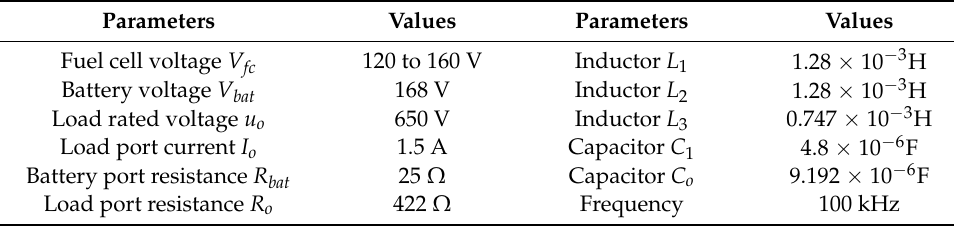
Table 2. Experimental parameters of the simulation